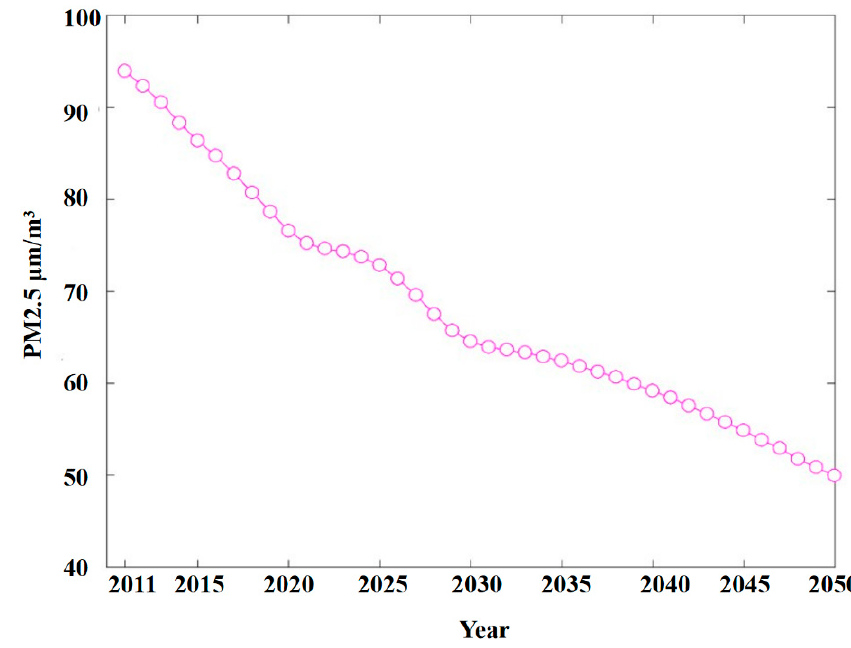
Figure 13. Impact of collaborative governance policy on PM2.5 in Beijing.